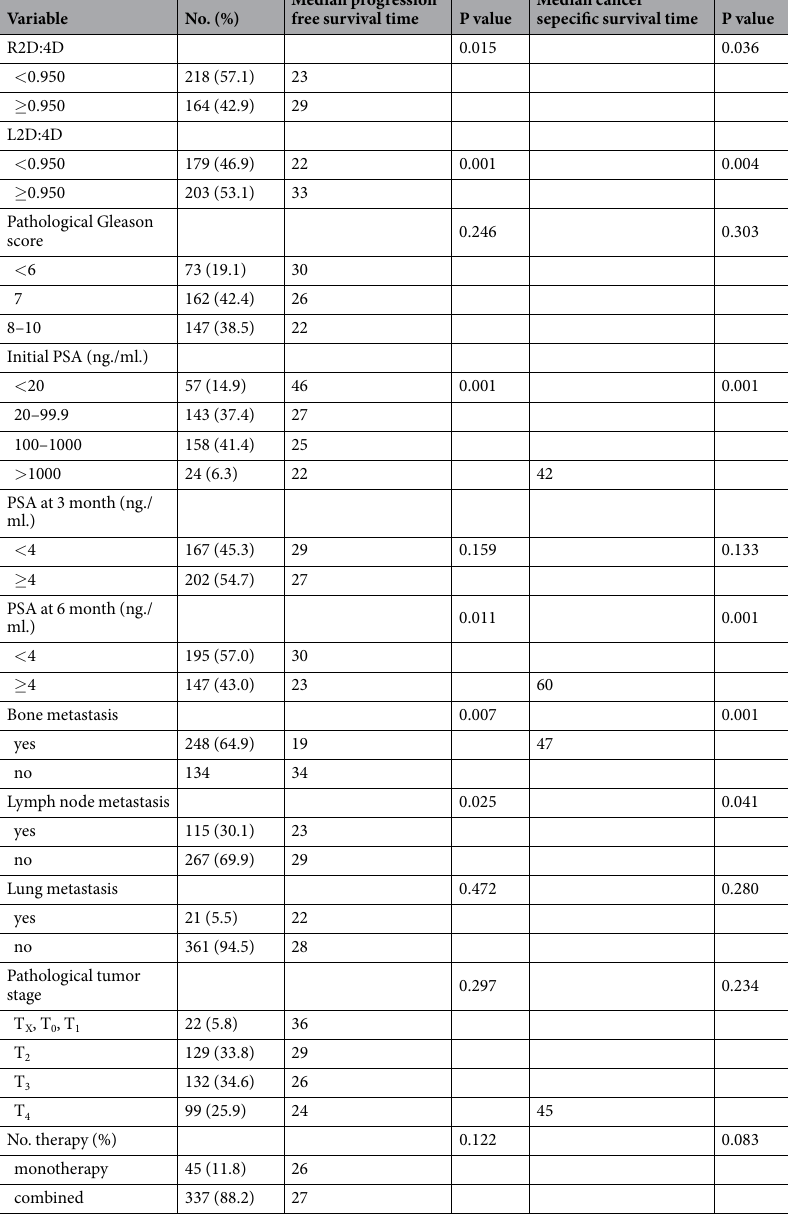
Table 3. Results of univariate analysis of prognostic factors for time to any progression free survival and cancer sepecific survival